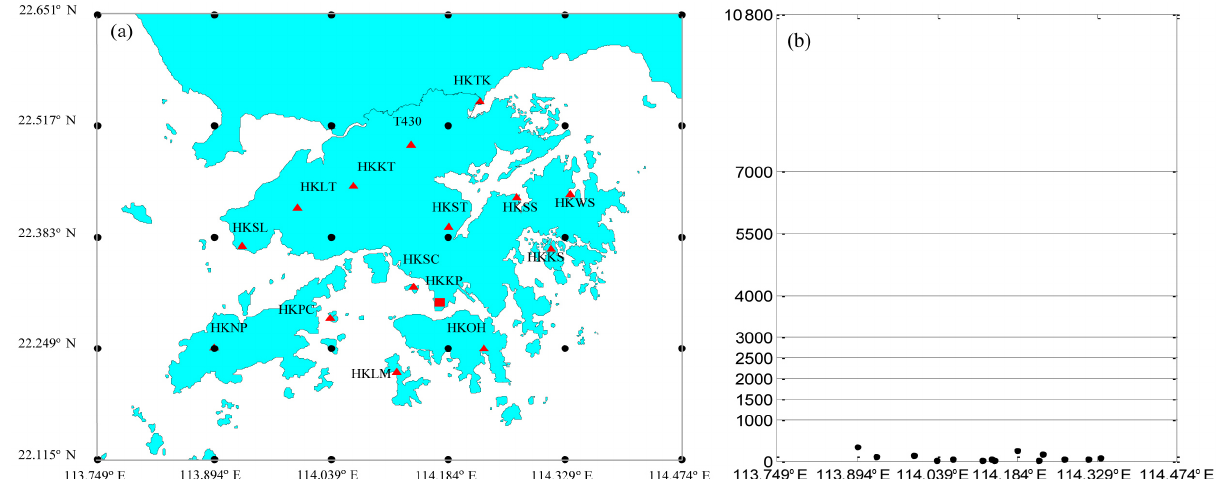
Figure 3. (a) Distribution of the Hong Kong reference stations (red triangle) and the King’s Park Meteorological Station (red square). The gray wireframe indicates the layer that contains voxel nodes (black dot) used in the tomographic processing. The study area was discretized into 6 × 4 × 10 voxel nodes for the water vapor tomography. (b) Vertical structure of the voxel node model used in the tomographic processing and height distribution of the GPS stations (black